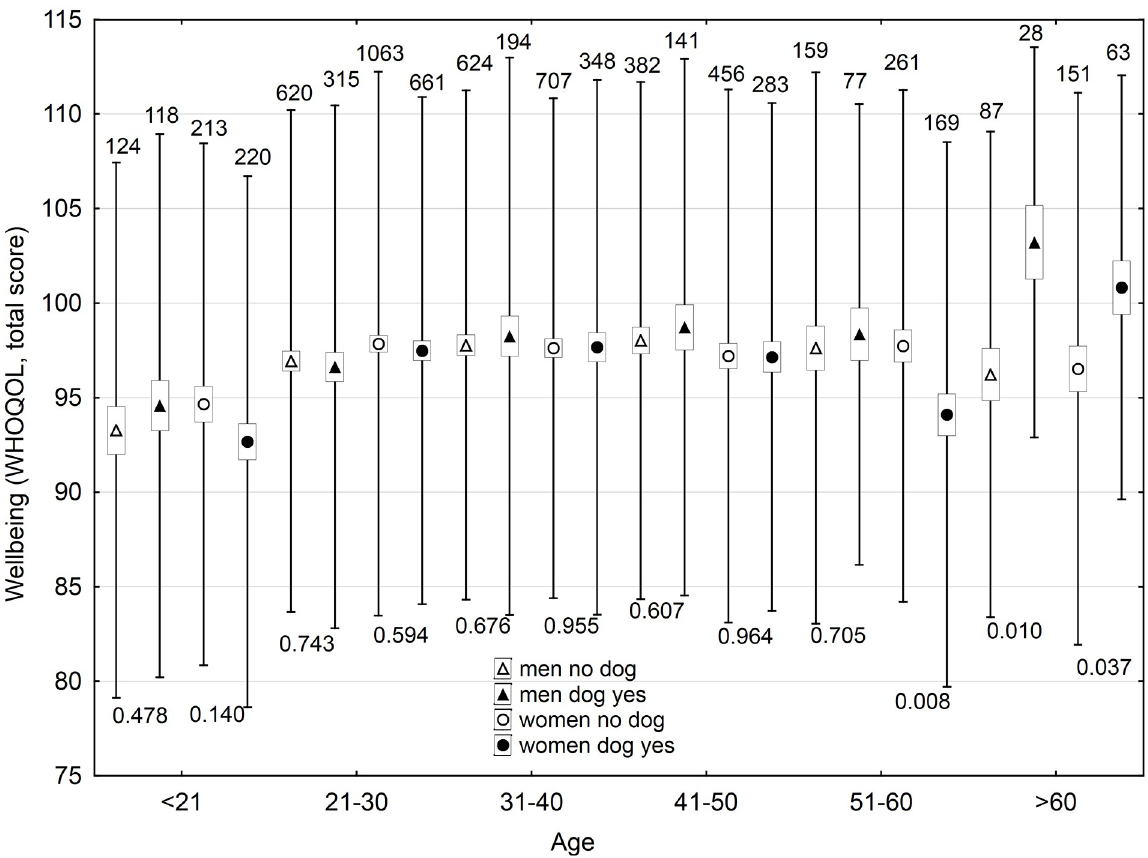
Fig 1. Effect of keeping a dog now on wellbeing of men and women of different age. The boxes, spreads, upper numbers and lower numbers show standard errors, standard deviations, numbers of subjects in particular category and p-values of two-sided t-tests, respectively.